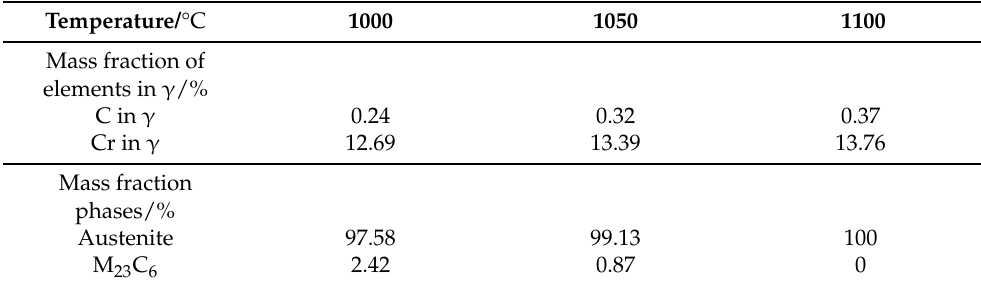
Table 4. Calculated composition of X30Cr13 at different temperatures using JMatPro ® .